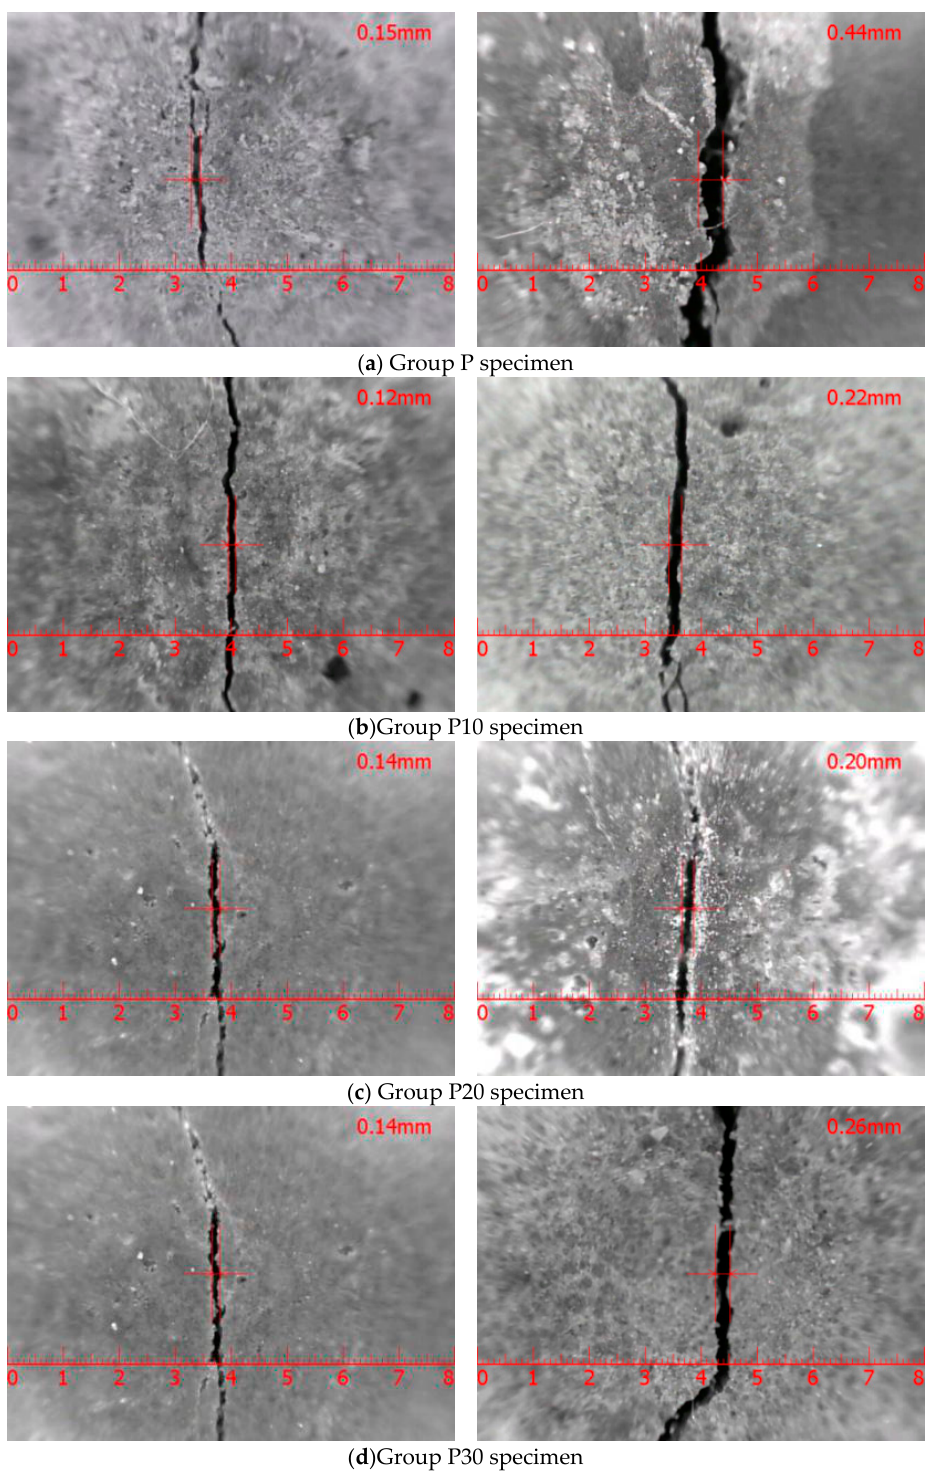
Figure 6. E ff ect of copper tailing powder content on crack width of concrete. ( a ) Constant-current acceleration test piece of Group P specimen; ( b ) constant-current acceleration test piece of Group P10 specimen; ( c ) constant-current acceleration test piece of Group P20 specimen; ( d ) constant-current acceleration test piece of Group P30